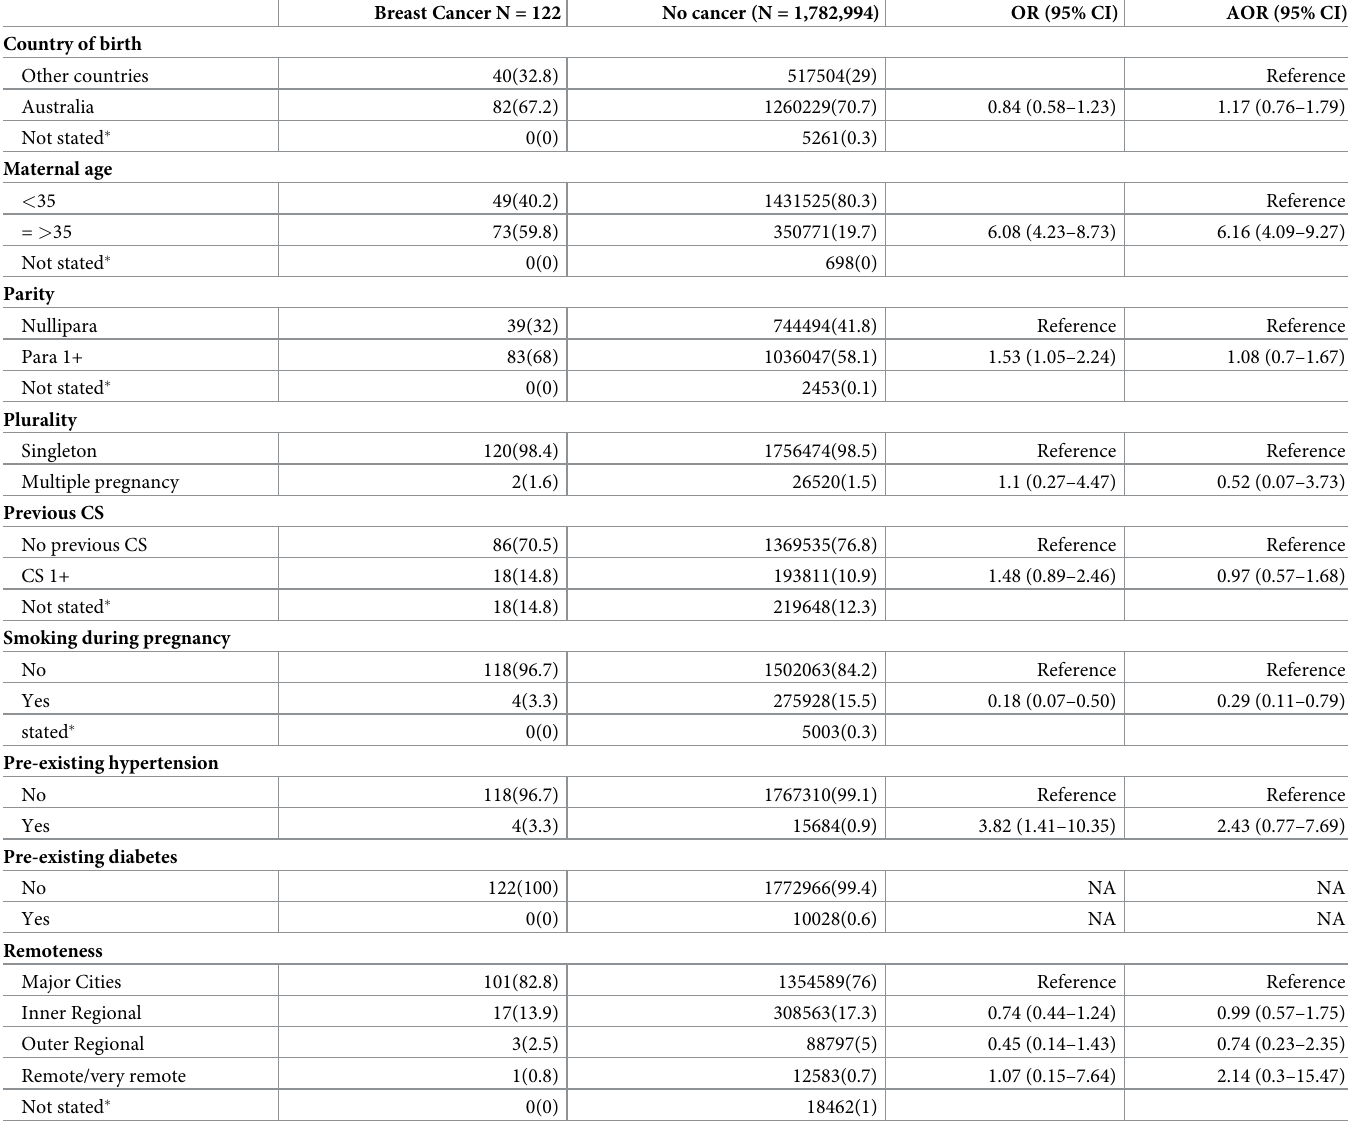
Table 1. Maternal characteristics and pre-existing